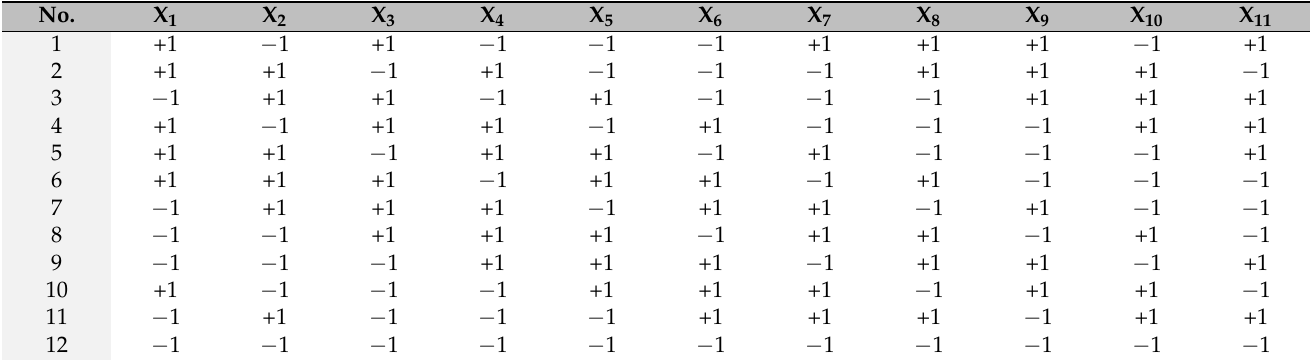
Table 6. The matrix of Plackett-Burman design (PBD) for eleven experimental